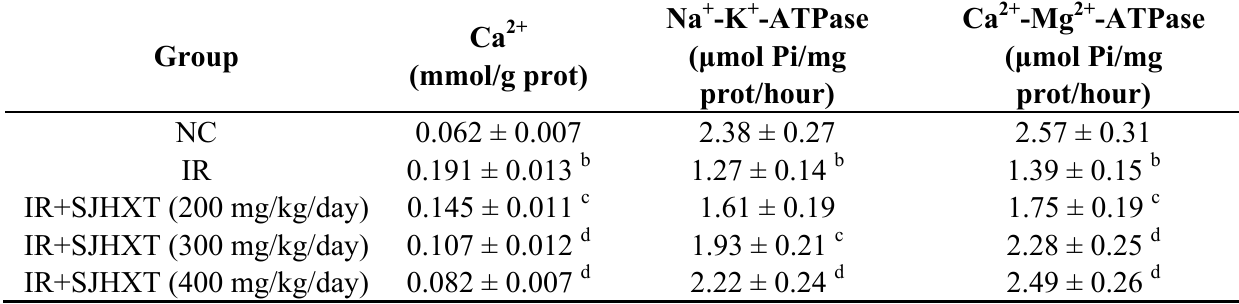
Table 4. Effect of SJHXT on skeletal muscle Ca 2+ level, Na + -K + -ATPase and Ca 2+ -Mg 2+ -ATPase activities.